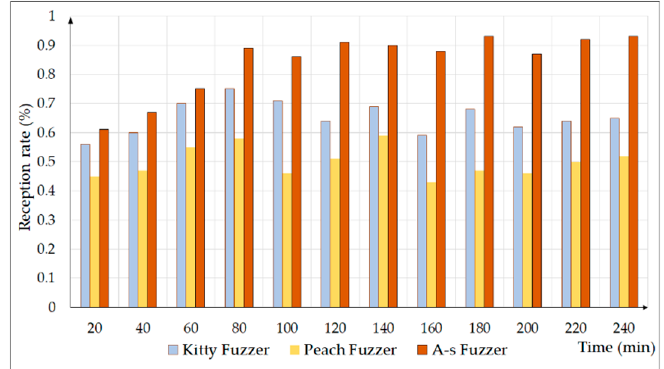
Figure 11. Comparing the reception rate of the three fuzzers. A-s, anti-sample.